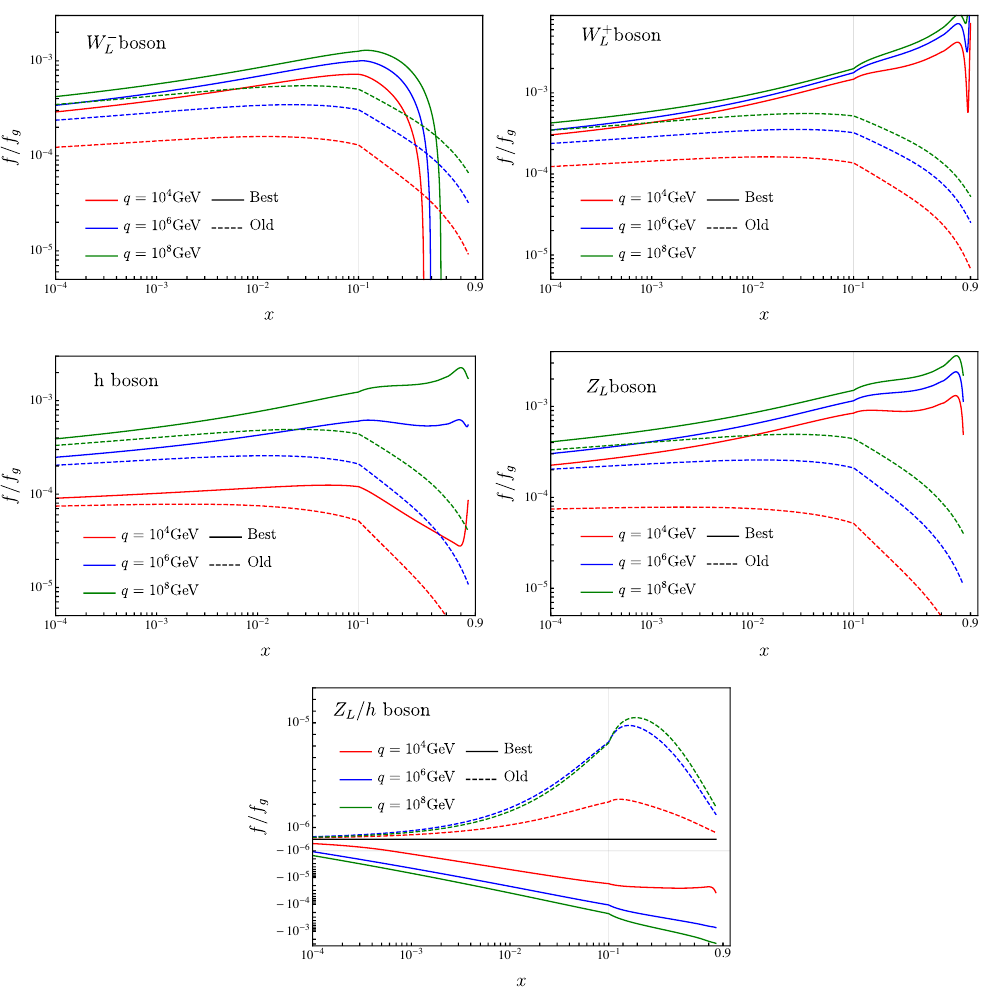
Figure 5 . Longitudinal gauge and Higgs boson PDFs normalized by the gluon PDF. The Z L =h PDF is purely imaginary and we show the result divided by i . The thin gray line shows where the scales on the x- and/or y-axes switch between linear and logarithmic.